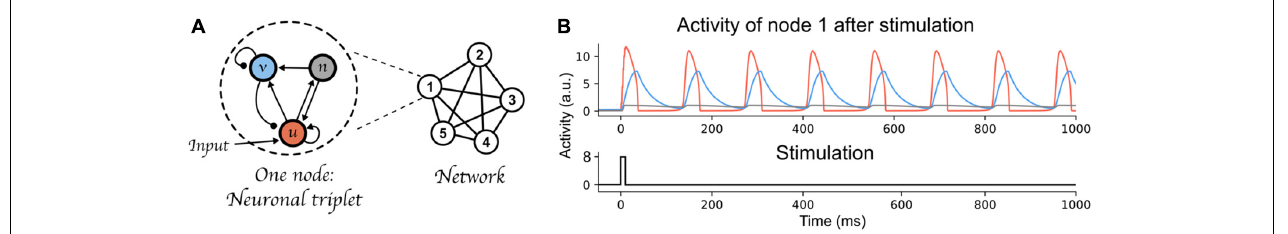
FIGURE 2 | Time-based binding network. (A) Each node of the network is a “neural triplet” composed of three components: A fast excitatory (u) neuron, an inhibitory (v) neuron, and a slow excitatory (n) neuron. Stimulation to a node affects unit u (as represented by the “Input” arrow). This architecture allows each node to start oscillating thanks to the excitatory-inhibitory pair of neurons (u and v, respectively), and maintain this oscillation through time (i.e., very slow decay) due to the slow excitatory neuron (n). When interconnected through excitatory-to-excitatory, and inhibitory-to-inhibitory connections, these nodes form a network that exhibits binding by phase and competition between active nodes or bound group of nodes. Synaptic weights are represented as lines between components or nodes: arrow ended lines represent excitatory connections, circle-ended lines represent inhibitory connections. (B) Top: Example of node 1 being activated by an input stimulation. The red curve represents the activity of the fast-excitatory neuron (u), the blue curve represents the activity of the inhibitory neuron (v), and the gray curve represents the activity of the slow-excitatory neuron (n). Bottom: stimulation time course.